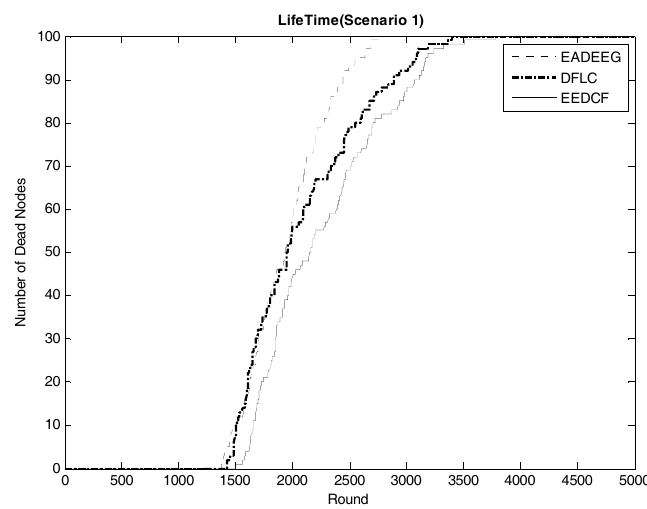
Figure 7. Comparison of network lifetime of the three algorithms in Scenario 1 (The vertical axis denotes the number of dead nodes, and the horizontal axis denotes the round number).